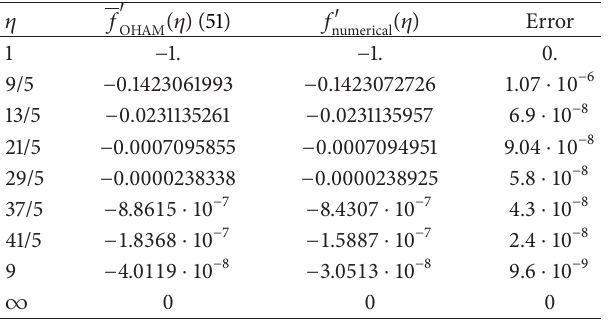
Table 10: Comparison between the first expression of the first-order 󸀠 (𝜂) obtained from approximate solutions 𝑓(𝜂) given by (53) obtained by OHAM and 󸀠 (𝜂)− numerical results for 𝛾 = 2 and 𝑆 = −1 (error = |𝑓 OHAM (𝜂)| 𝑓 numerical